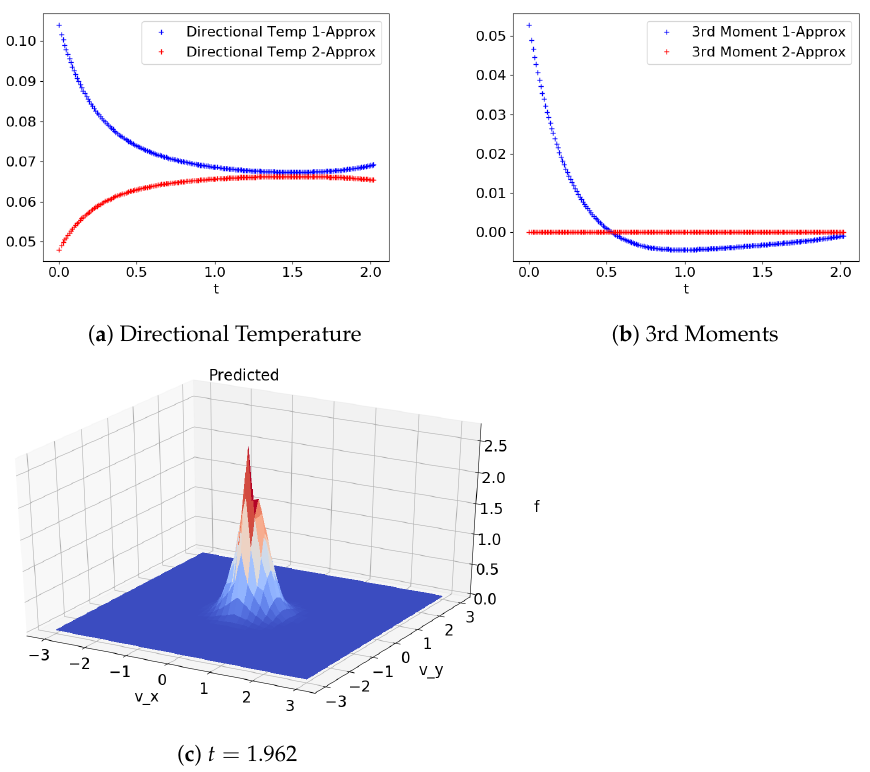
Figure 9. Long term behavior of predicted solution, Case 116. Key moments and domain slice are shown. Divergence of the directional temperature is seen around t = 1.75, and the plot of the solution is visibly degraded. Time axis is normalized to the maximum time for which training data